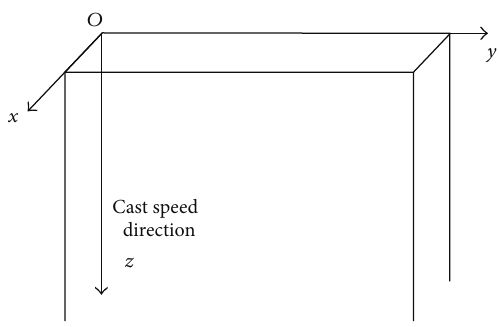
Figure 1: Schematic representation of steel